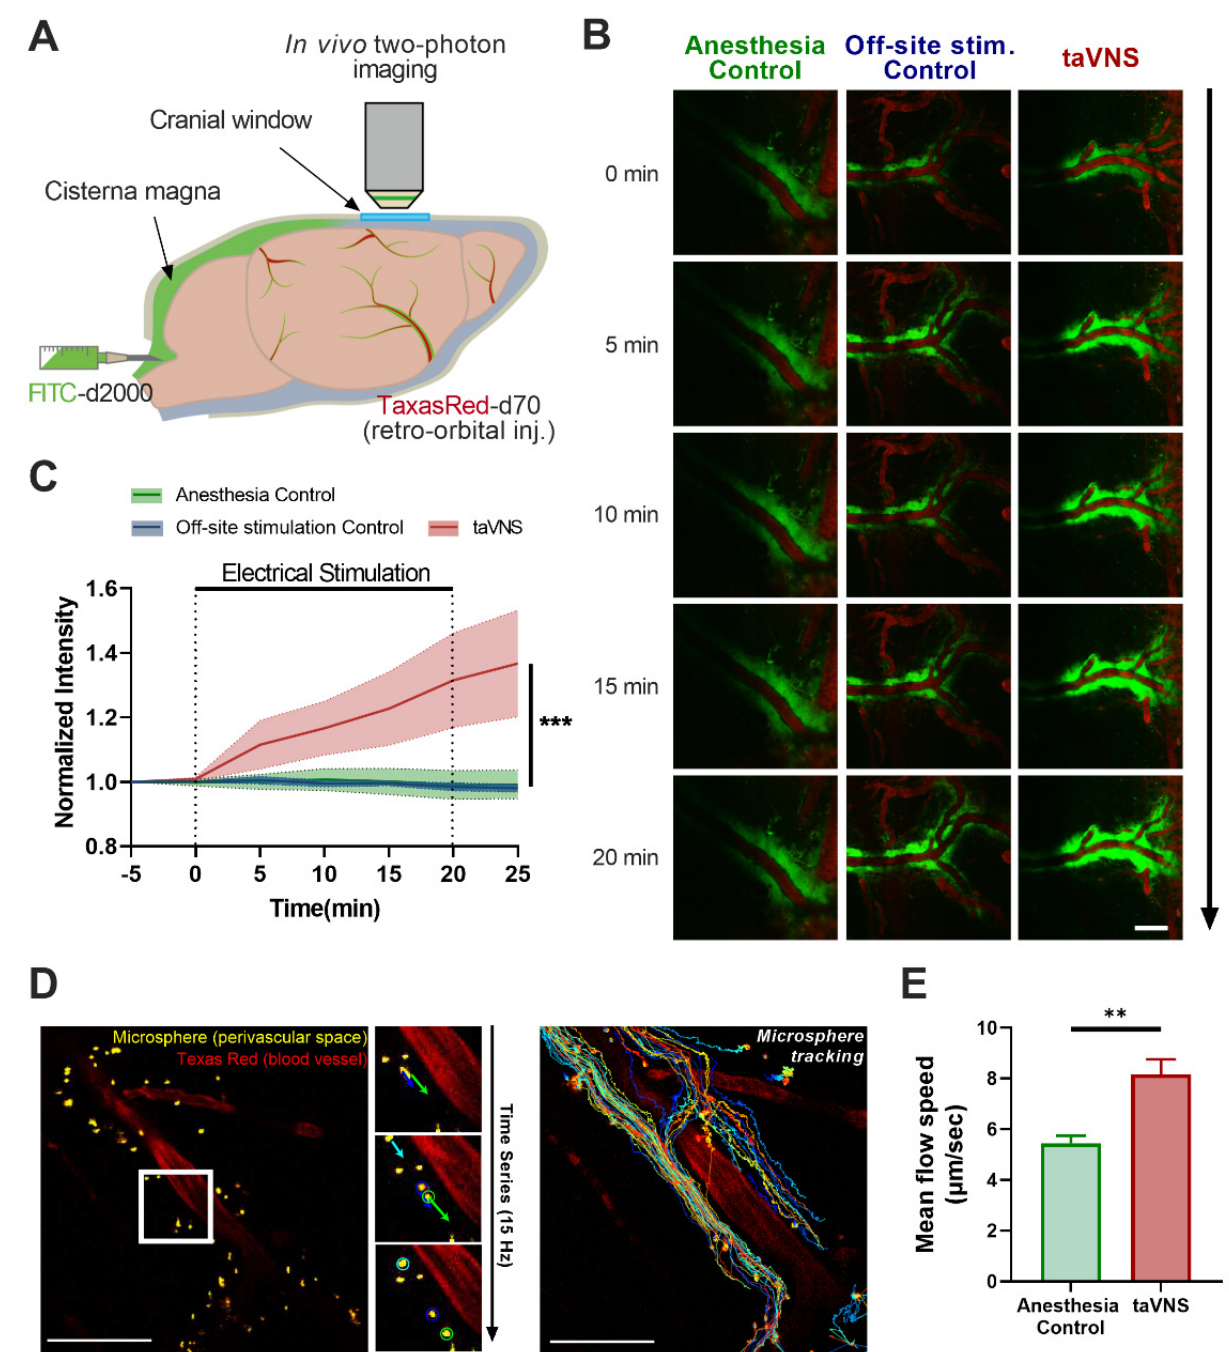
Figure 2. taVNS-enhanced cortical CSF circulation. ( A ) Schematic image showing CSF tracer (FITC- dextran) injection via cisterna magna cannulation and in vivo two-photon imaging of cortical CSF dynamics. ( B ) Representative images of the cortical CSF tracer after 20 min of stimulation. Scale bar: 100 μ m. ( C ) taVNS (n = 5) promoted CSF tracer fluorescence intensity compared to the off-site stimulation control (n = 5, p < 0.001) and anesthesia (n = 6, p < 0.001) groups. ( D ) Representative images showing microspheres moving in perivascular space and microsphere particle tracking analysis. Scale bar: 50 μ m. ( E ) Mean flow speed of microspheres increased in the taVNS group (n = 29) compared to anesthesia control (n = 14) each from 2 mice. The error bars indicate the SEM. Two- way repeated-measures analysis of variance (ANOVA) and unpaired t -test were used. ** p < 0.01; *** p < 0.001.